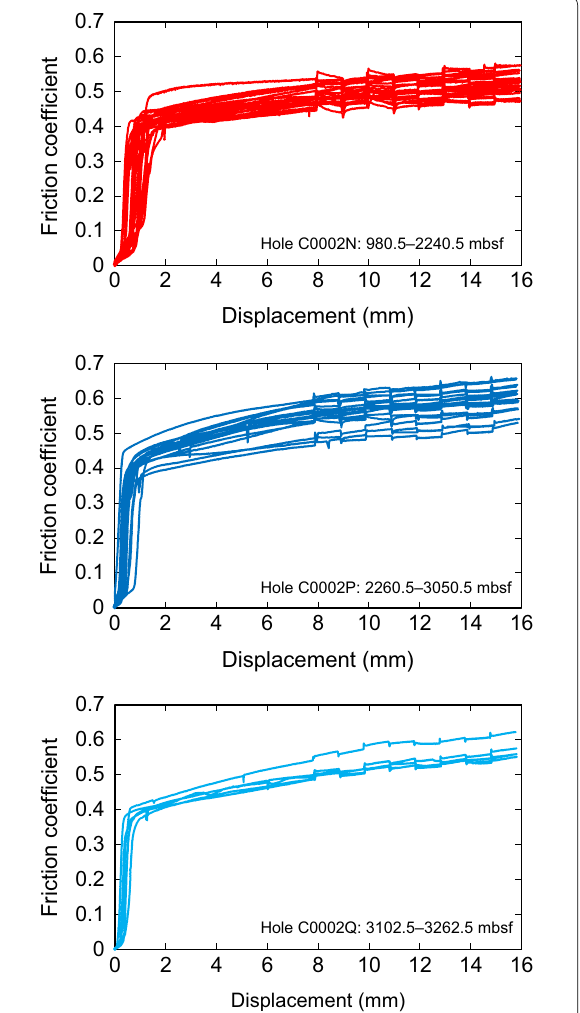
Fig. 4 Results of the frictional experiments of the cuttings samples collected from Holes C0002N (980.5–2240.5 mbsf), C0002P (2260.5–3050.5 mbsf), and C0002Q (3102.5–3262.5 mbsf). The experiments were run at a slip velocity of 3 µm/s for the first 8 mm of displacement, followed by stepwise changes of 0.3, 3, and 33 µm/s to test the velocity dependence of